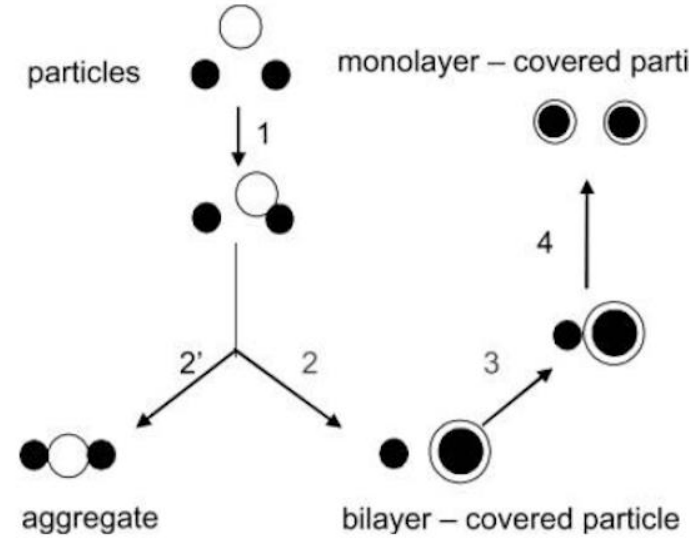
Figure 17. The interaction between one bilayer vesicle and two particles. In the first step (step 1 ), electrostatic and/or van der Waals and/or hydrophobic attraction leads to aggregation of a vesicle and a particle. These same interaction forces may disrupt the vesicle bilayer and promote bilayer adsorption onto the microsphere (step 2 ) and/or further aggregation with the other microsphere (step 2′). The adsorbed bilayer may attract the second microsphere (step 3 ). The hydrophobic interaction between an eventually hydrophobic surface and the hydrocarbon chains in the bilayer may completely destroy the bilayer structure, flip-flopping the hydrocarbon chains onto the particle surface and generating a monolayer coverage on each microsphere (step 4 ). Adapted from [206] with permission from Elsevier, Copyright 1999.